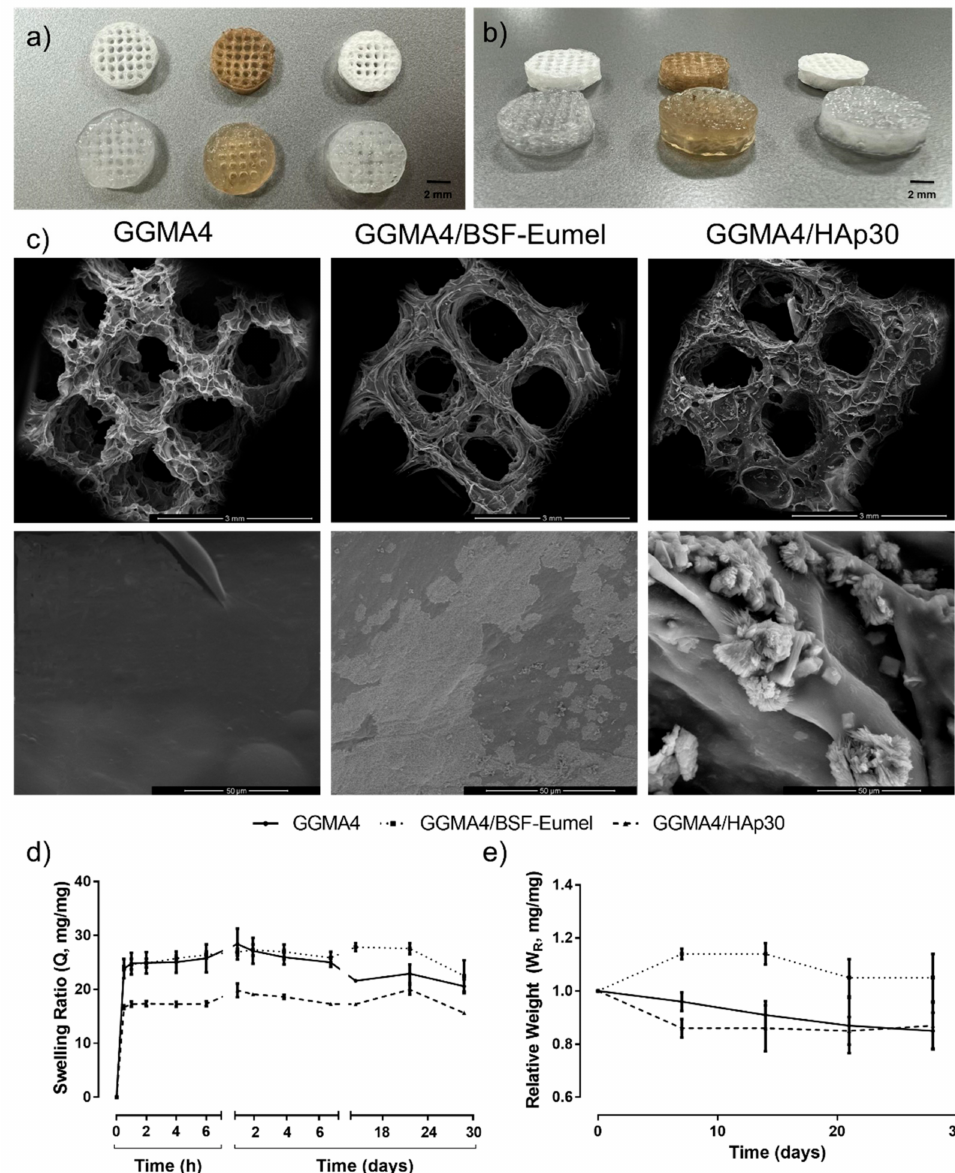
Figure 5. Optical images of dry (top row) and wet (bottom row) GGMA4 (left), GGMA4/BSF-Eumel (middle) and GGMA4/HAp30 (right) 3D-printed scaffolds with 45% infill (scale bar: 2 mm): ( a ) top view and ( b ) lateral view. ( c ) SEM micrographs of GGMA4 (left), GGMA4/BSF-Eumel (middle) and GGMA4/HAp30 (right) 3D-printed scaffolds with 45% infill (Mag. 50 × and scale bar: 3 mm (top row); Mag. 2000 × and scale bar: 50 µ m (bottom row)). ( d ) Swelling ratio (Q, expressed as a dimensionless ratio) and ( e ) relative weight (W R , expressed as a dimensionless ratio) of GGMA4, GGMA4/BSF-Eumel and GGMA4/HAp30 3D-printed scaffolds as function of time in DMEM-HG supplemented with antibiotics up to 28 days in physiological conditions (pH 7.4 at 37 ◦